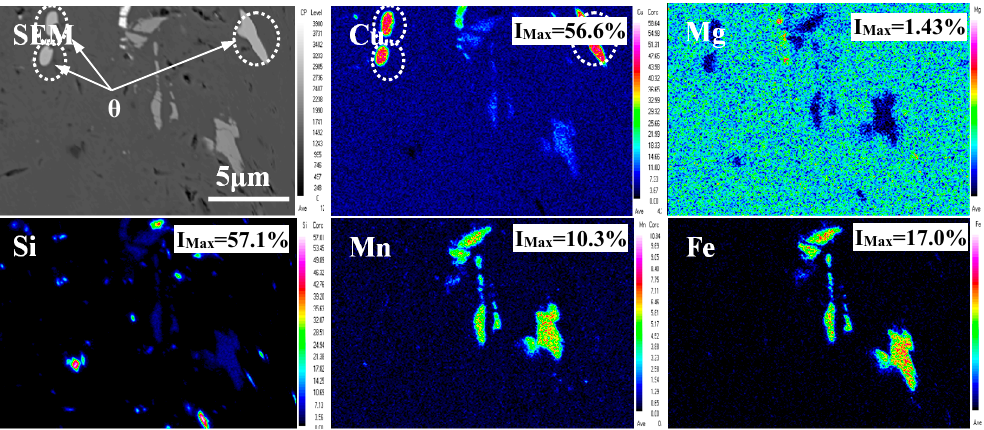
Figure 8. Elemental mapping of the as-quenched Alloy 4 examined by EPMA.